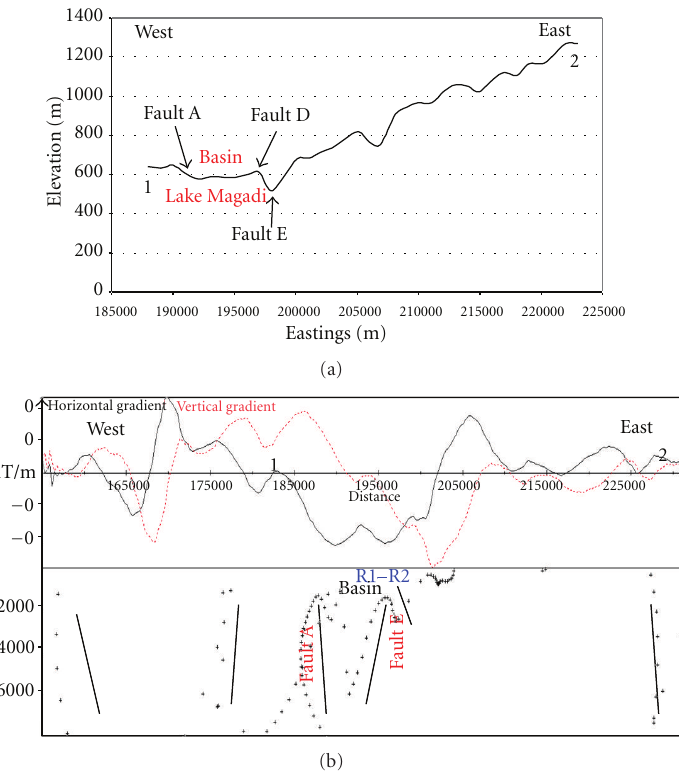
Figure 12: (a) Extracted topography elevations of Lake Magadi area from Aster DEM along flight line 322 showing surface faults and grabens. (b) 2D Euler deconvolution solutions from aeromagnetic data along flight line 322. The plus signs are structural index of